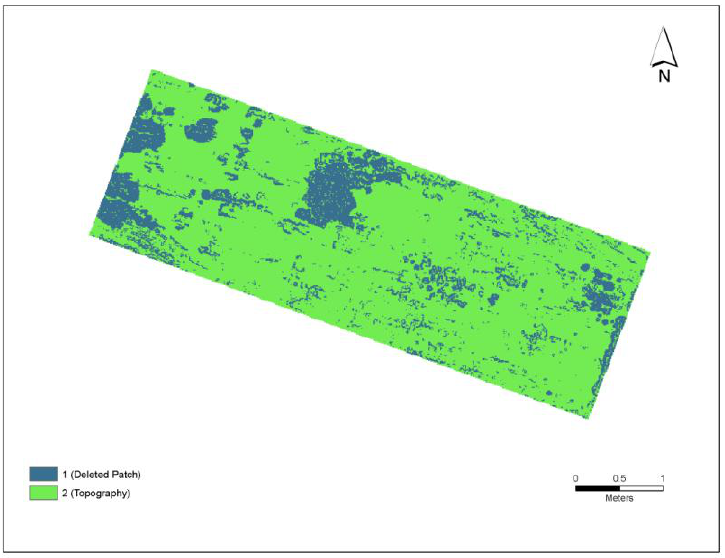
Figure 6. Plot with vegetation areas removed. A slope threshold of 60° was used to delete the vegetation patches. Blue patches in the map are vegetation areas converted to null